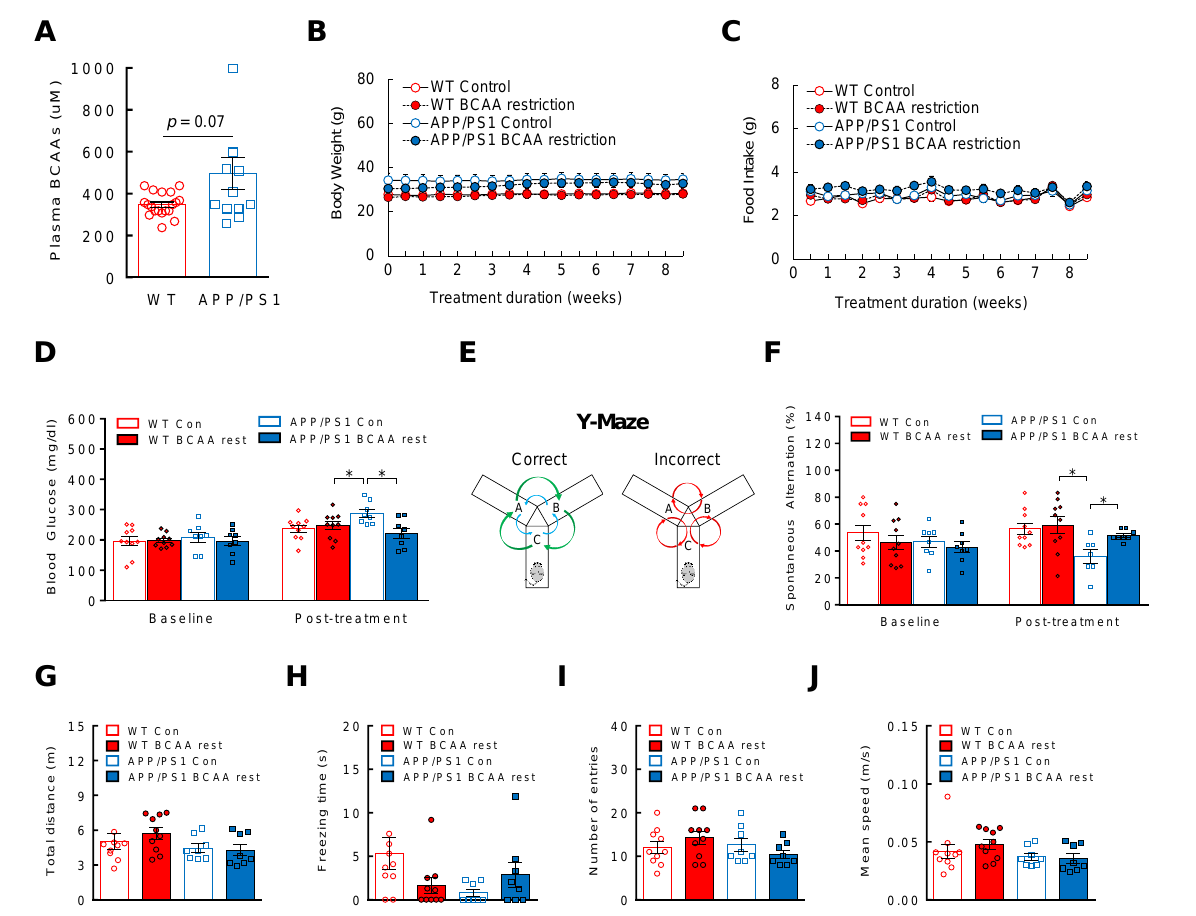
Figure 4. BCAA restriction delays the onset of cognitive deficit in APP/PS1 mice. 11-month-old WT or APP/PS1 mice without cognitive impairment were placed on a control diet or BCAA-restricted (50%) diet, iso-caloric and iso-nitrogenous, for two months. ( A ) Plasma BCAA levels at baseline. ( B ) BCAA restriction does not affect body weight or ( C ) Food intake. ( D ) Blood glucose before and after treatment. ( E ) Schematic of Y-maze behavioral test. ( F ) Spontaneous alternation (%) before and after treatment. ( G ) Total distance traveled, ( H ) Freezing time, ( I ) Number of arm entries, and ( J ) Mean speed during Y-maze test. WT control or BCAA restriction group ( n = 10/group); APP/PS1 control or BCAA restriction group ( n = 8/group). Groups with different letters are significantly different from each other with p < 0.05.